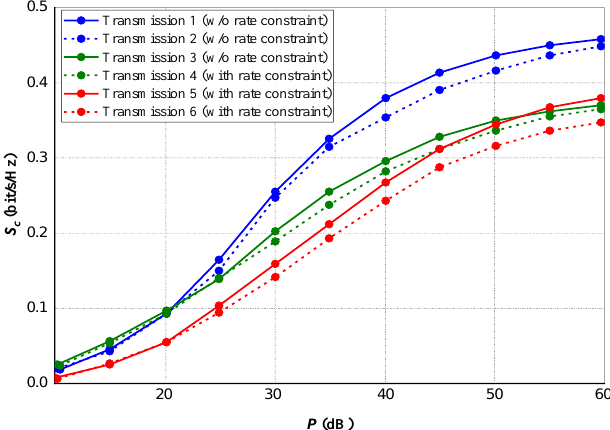
Figure 7. Maximum realized privacy capacity for multiple sources